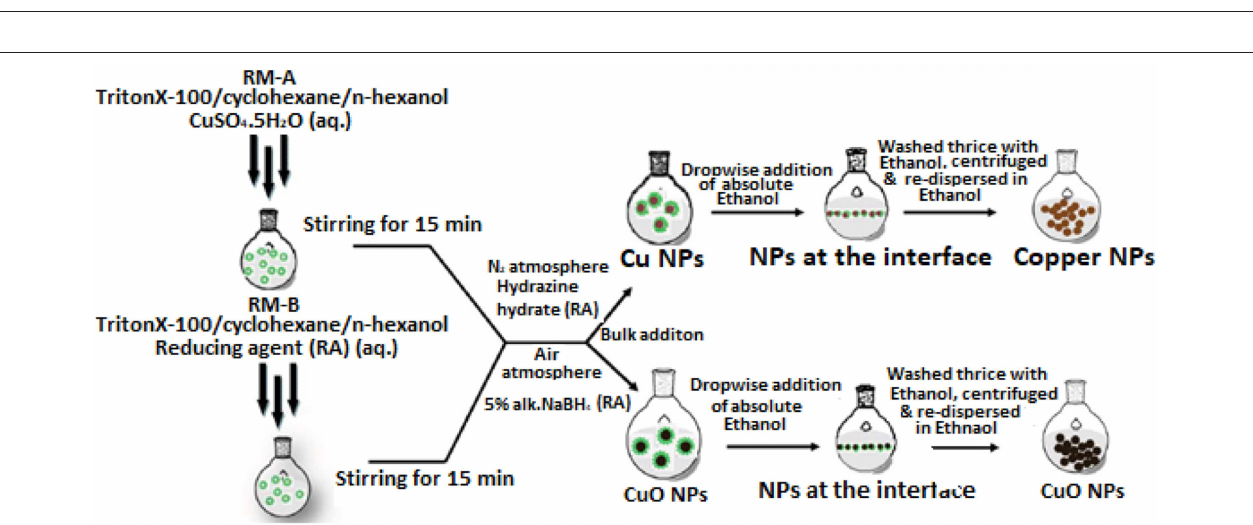
FIGURE 5 | Polyol route for the synthesis of nanoparticles [adapted and modified from Dong et al. (2015)].